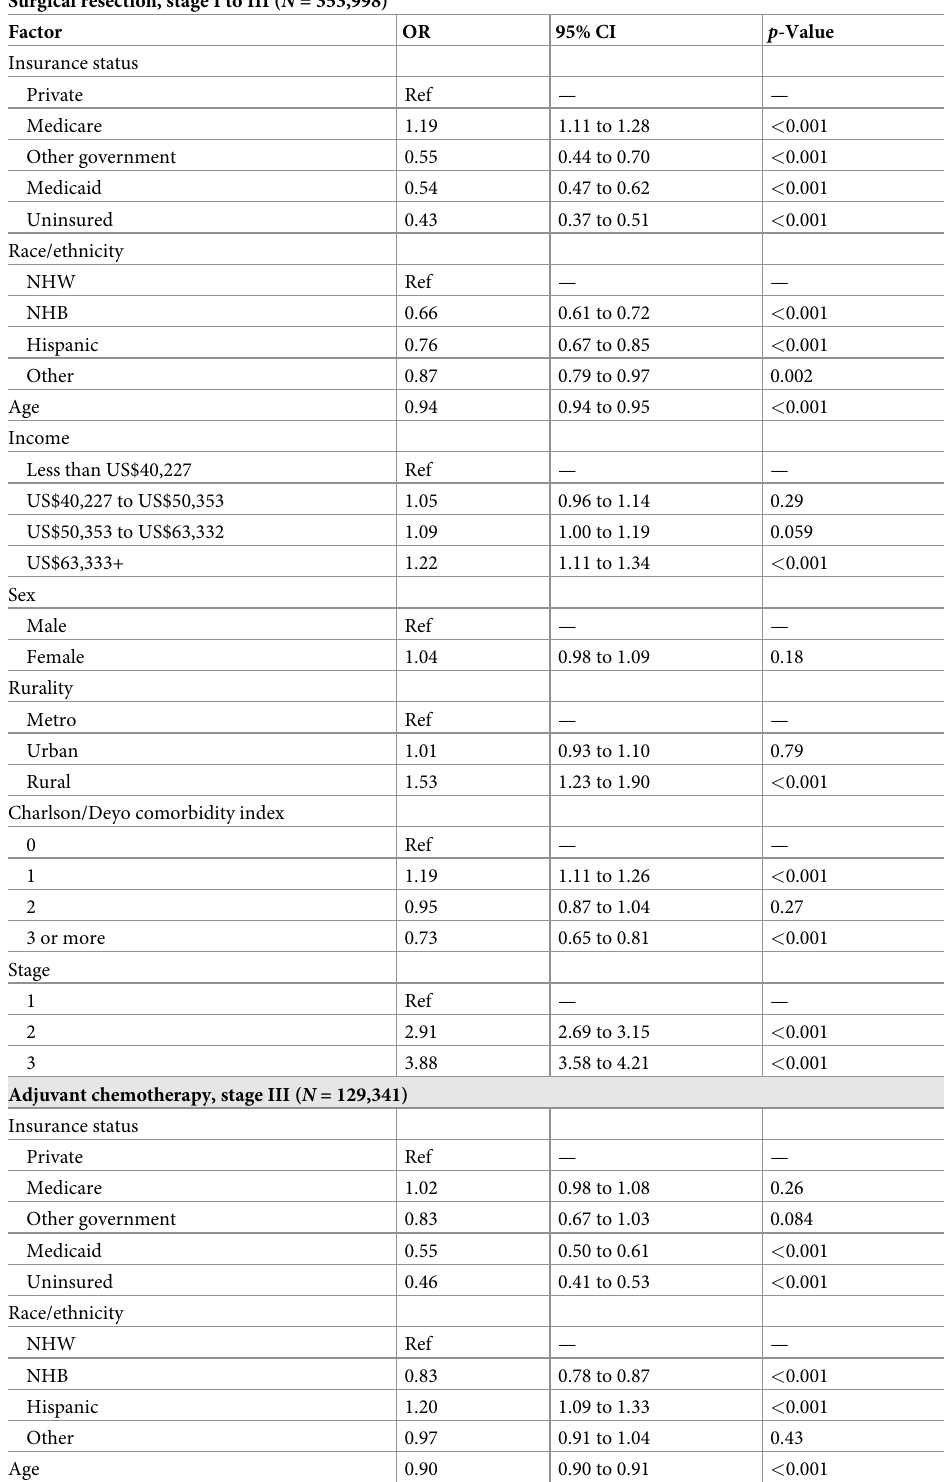
Table 4. Adjusted odds of undergoing surgical resection or receiving adjuvant